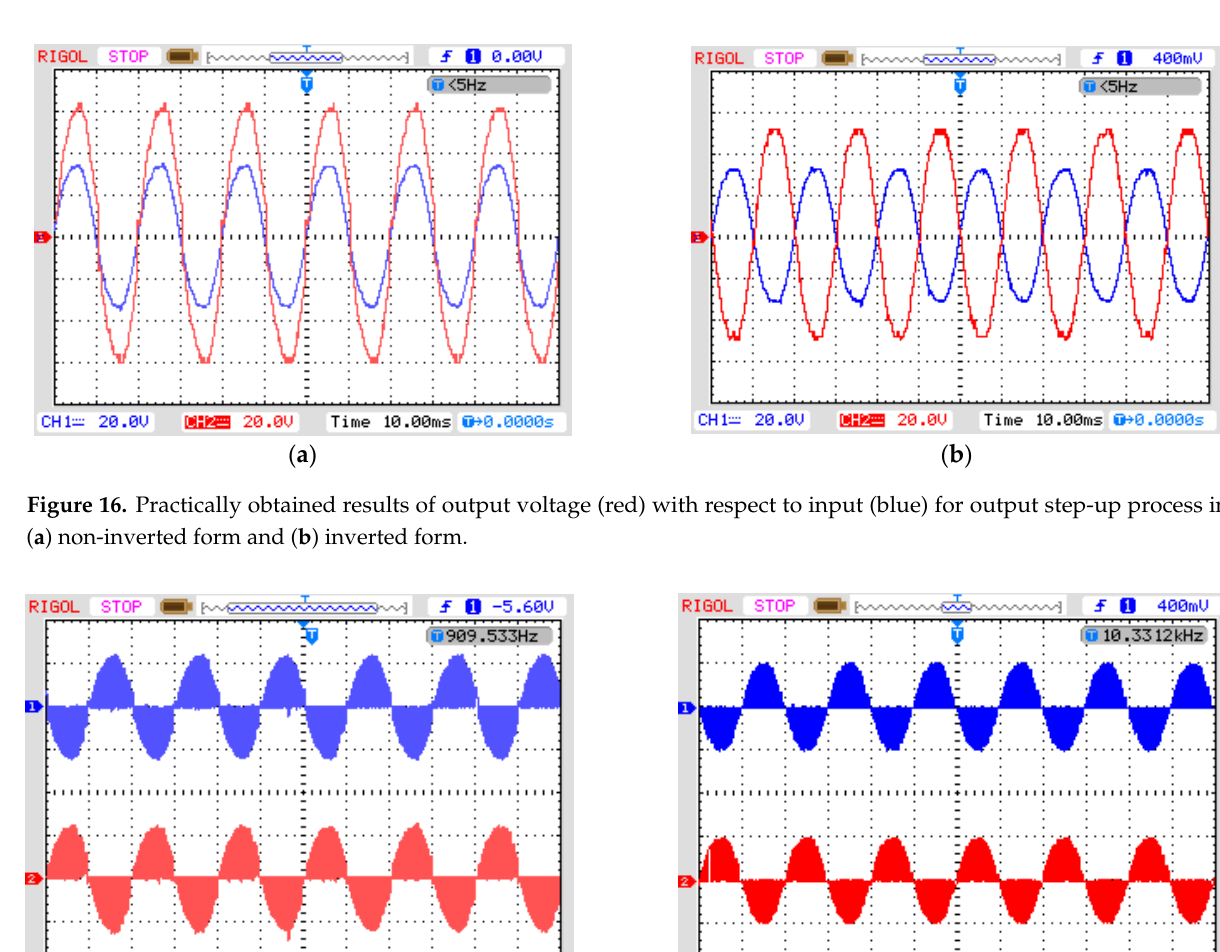
Figure 15. Practically obtained results for output step-down process across T r 1 , D 1 (blue) and T r3 , D 3 in ( a ) non-inverted